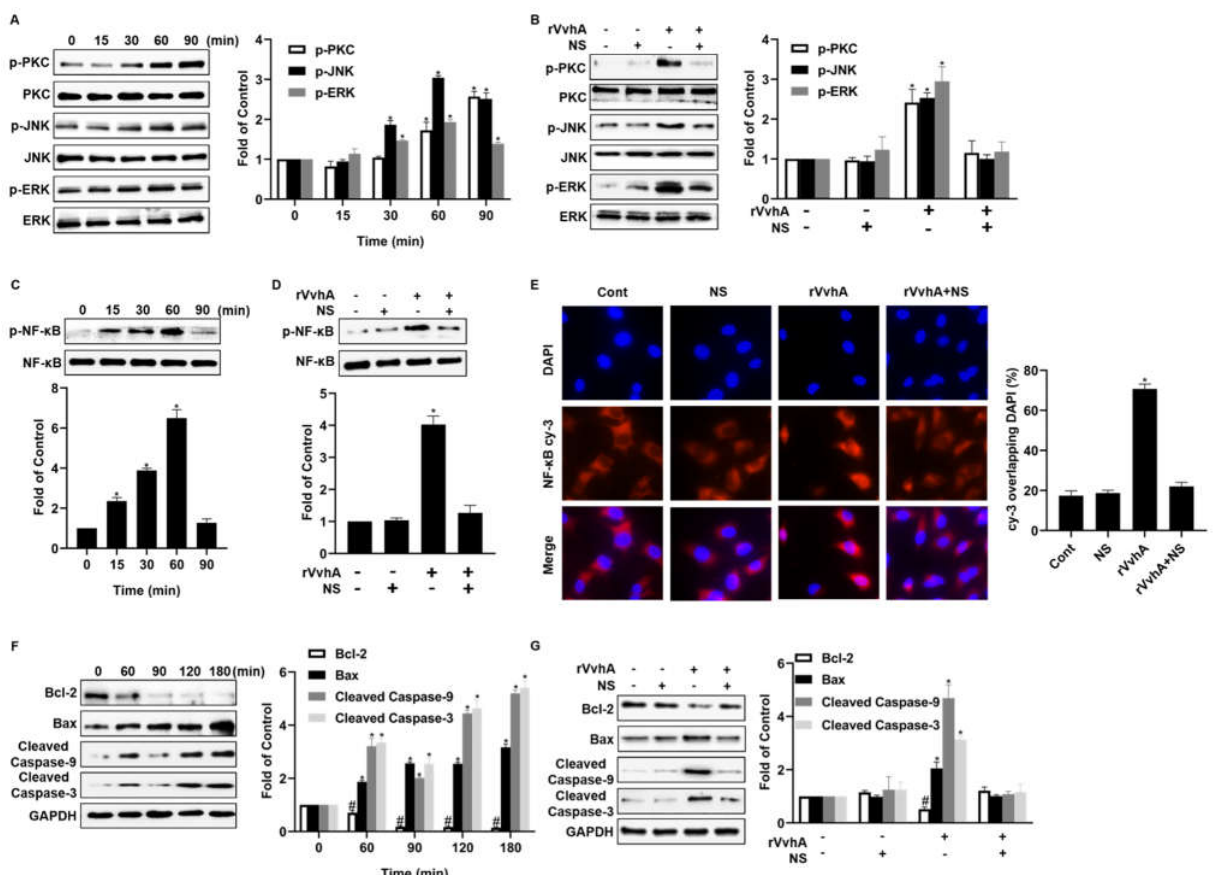
Figure 4. NSs inhibited rVvhA-induced activation of the PKC/JNK/ERK and NF-κB pathways. ( A ) The phosphorylation of PKC/JNK/ERK in HPAECs treated with rVvhA (500 ng/mL) was examined by Western blotting. The data represent the means ± SE. n = 3. * p < 0.05 versus 0 min. ( B ) The phos- phorylation of PKC/JNK/ERK in HPAECs treated with NSs (40 μg/mL) and rVvhA (500 ng/mL) for 60 min. The data represent the means ± SE. n = 3. * p < 0.05 versus Cont. ( C ) The phosphorylation of NF-κB in HPAECs treated with rVvhA (500 ng/mL) was examined by Western blotting. The data represent the means ± SE. n = 3. * p < 0.05 versus 0 min. ( D ) The phosphorylation of NF-κB in HPAECs treated with NSs (40 μg/mL) and rVvhA (500 ng/mL) for 60 min. The data represent the mean ± SE. n = 3. * p < 0.05 versus Cont. ( E ) Nuclear accumulation of NF-κB was examined after 60 min by immunostaining with a Cy3-labeled NF-κB p65 antibody (Original magnification × 400). ( F ) HPAECs were incubated with rVvhA (500 ng/mL) for 180 min, and then Bcl-2 and Bax were ana- lyzed by Western blotting. The data represent the means ± SE. n = 3. * p < 0.05 versus 0 min, # p < 0.05 versus 0 min. ( G ) The expression of Bcl-2 and Bax was measured in the presence of NSs. The data represent the means ± SE. n = 3. * p < 0.05 versus Cont, # p < 0.05 versus Cont.